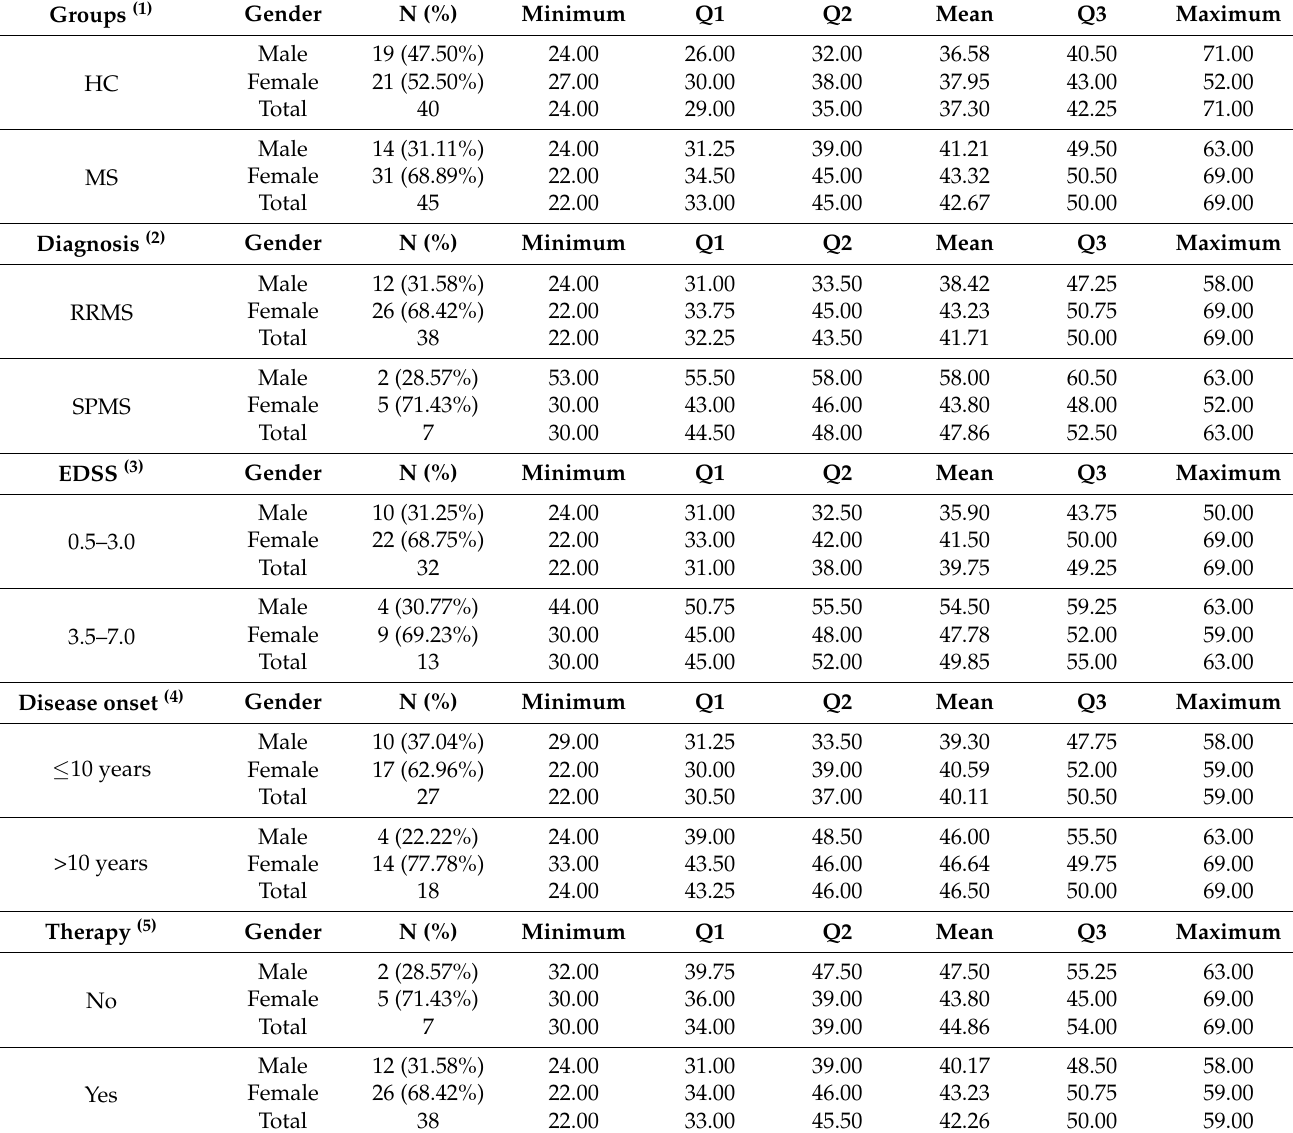
Table 1. Age distribution and boundaries (Q1 to Q3) for its partition in